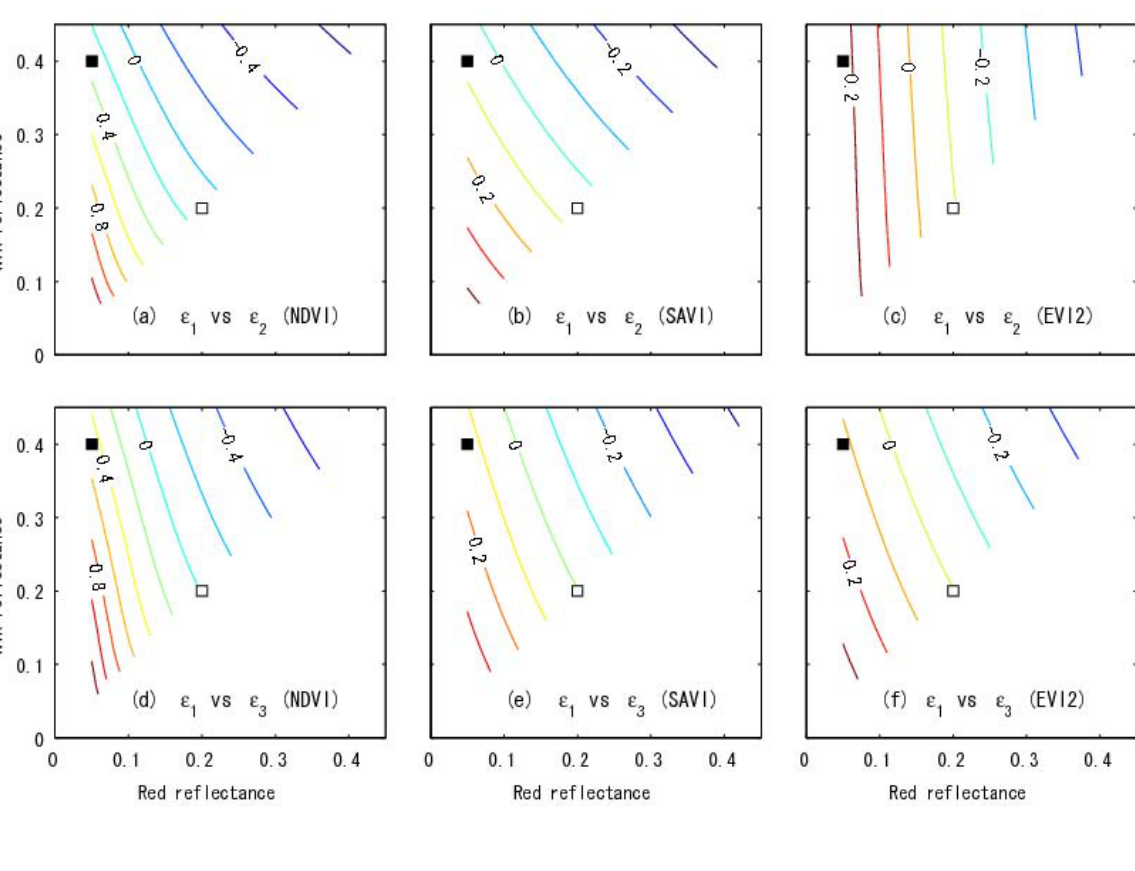
Figure 9. Results of the numerical simulation describing the distribution of tan θ on a log 0 scale over the red-NIR reflectance space, for comparing the performance of algorithm-1 and -2, or algorithm-1 and -3 (comparison of the inter-algorithm relationship) using EM1 as the endmember spectra. The results indicate the influences in the target spectrum and the choice of VI on tan θ . ( a – c ) show the tan θ -map for algorithm-1 and -2 using NDVI, SAVI, and 0 0 EVI2 as the endmember models.( d – f ) show the tan θ -map for algorithm-1 and -3 using 0 those VIs as the